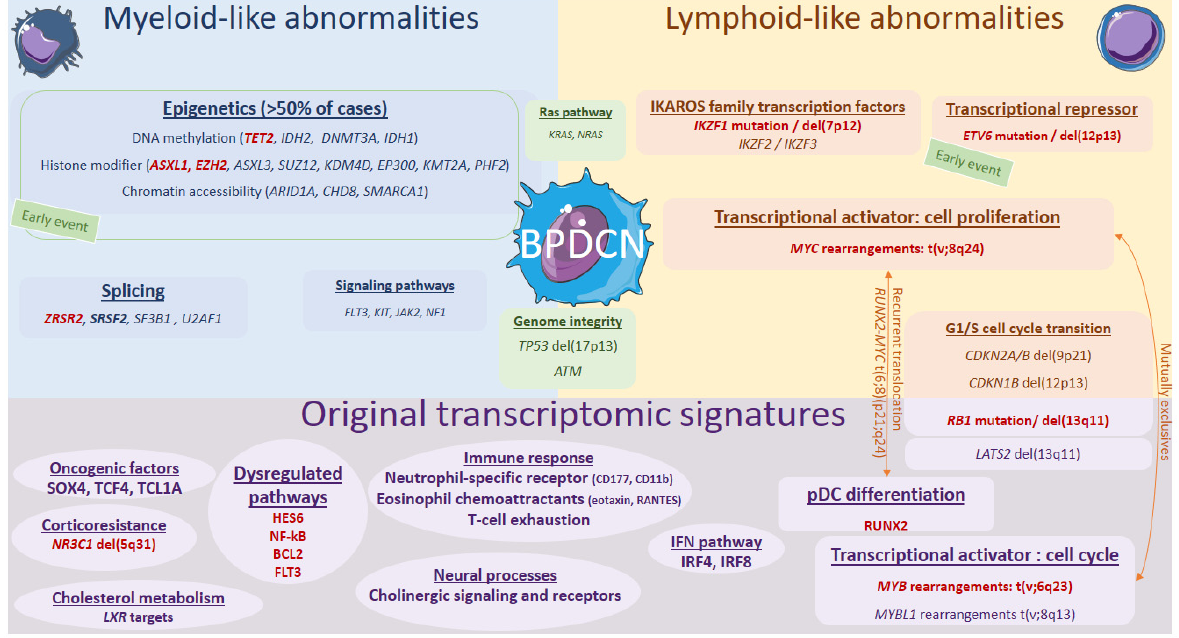
Figure 2. Genomics and transcriptional landscape of BPDCN. The genomic landscape of BPDCN include a combination of myeloid-like and lymphoid-like mutations and cytogenetic defects within a complex landscape, with frequent complex karyotypes. The transcriptional program of BPDCN is made of a diversity of original factors: RUNX2, MYB, IFN pathway, neural processes, cholesterol metabolism, corticoresistance factor, and original oncogenic